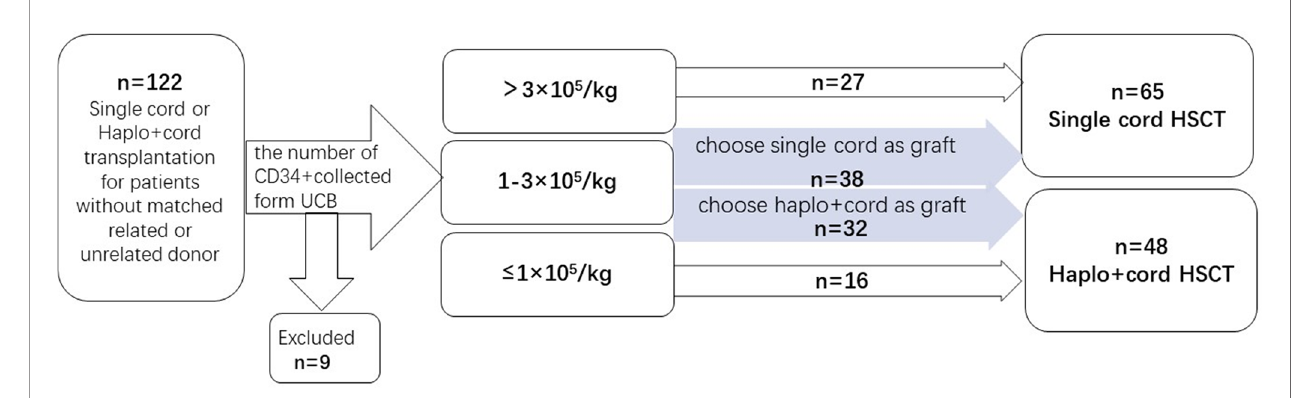
FIGURE 1 | Flowchart of